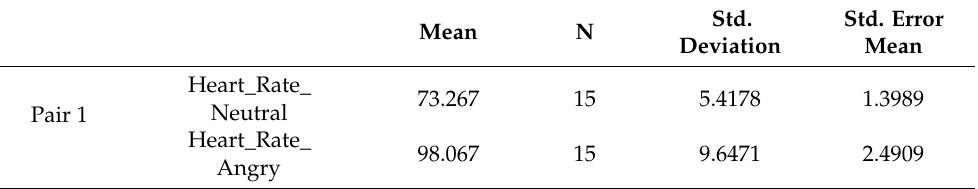
Table 10. Paired samples statistics for heart rate (neutral to angry